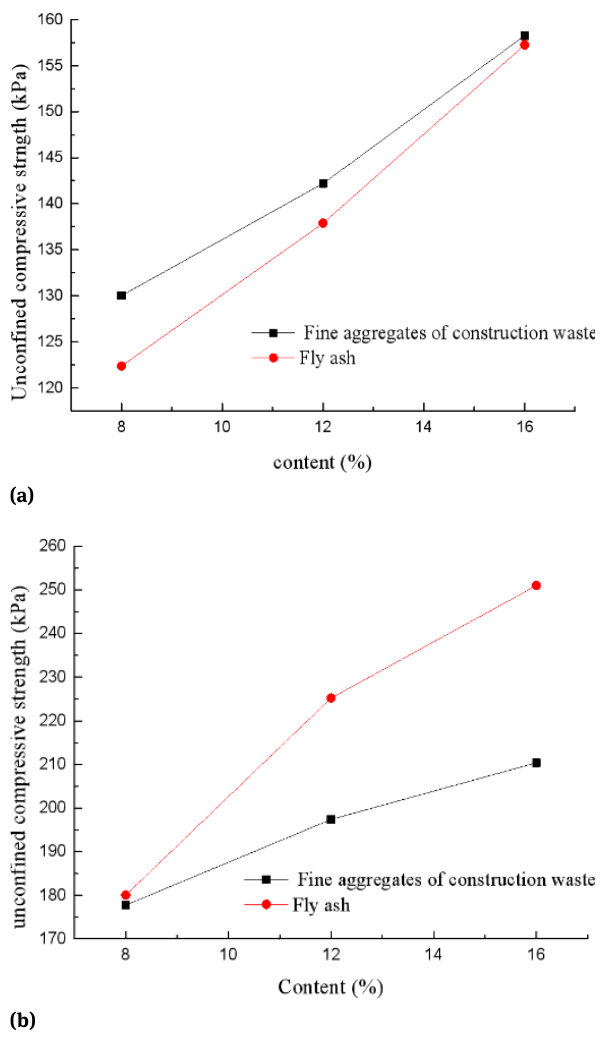
Figure 9: Relationship of unconfined compressive strength to con- tent of additives during different curing times. (a) for 7 d, (b) for 28